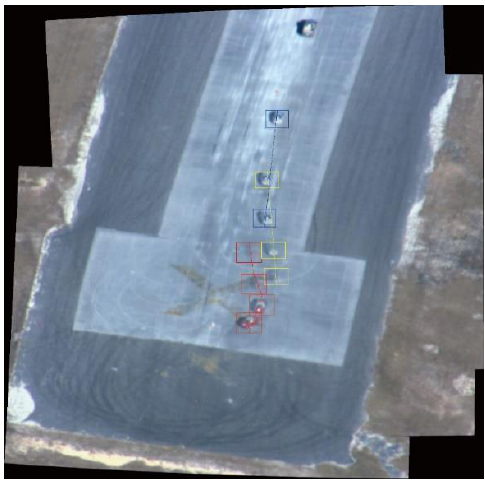
Figure 2. The trajectory of an object in multiple images.